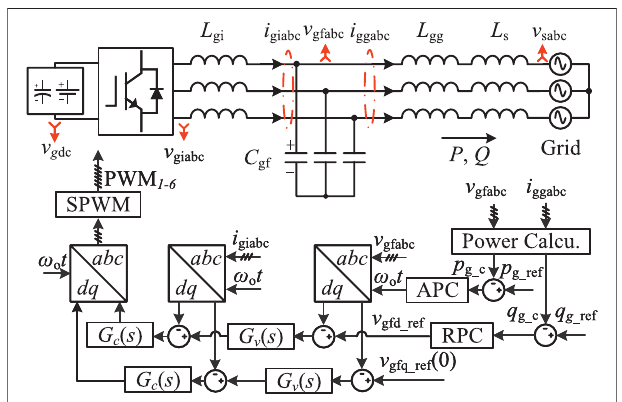
FIGURE 1 | System con fi guration of grid-forming